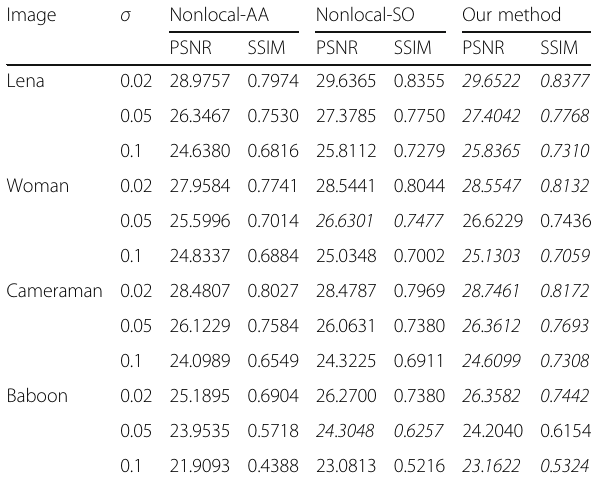
Table 1 Comparisons of the results using different models based on different images